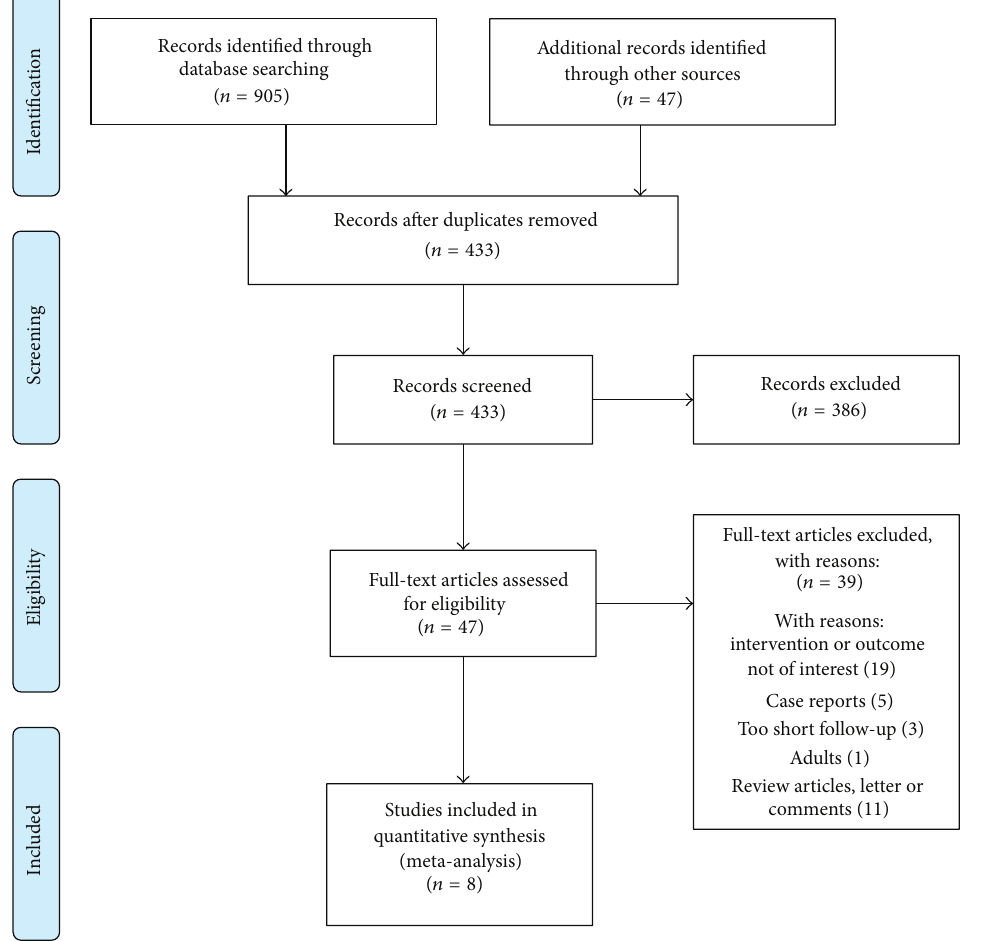
Figure 1: Results of literature search strategy.